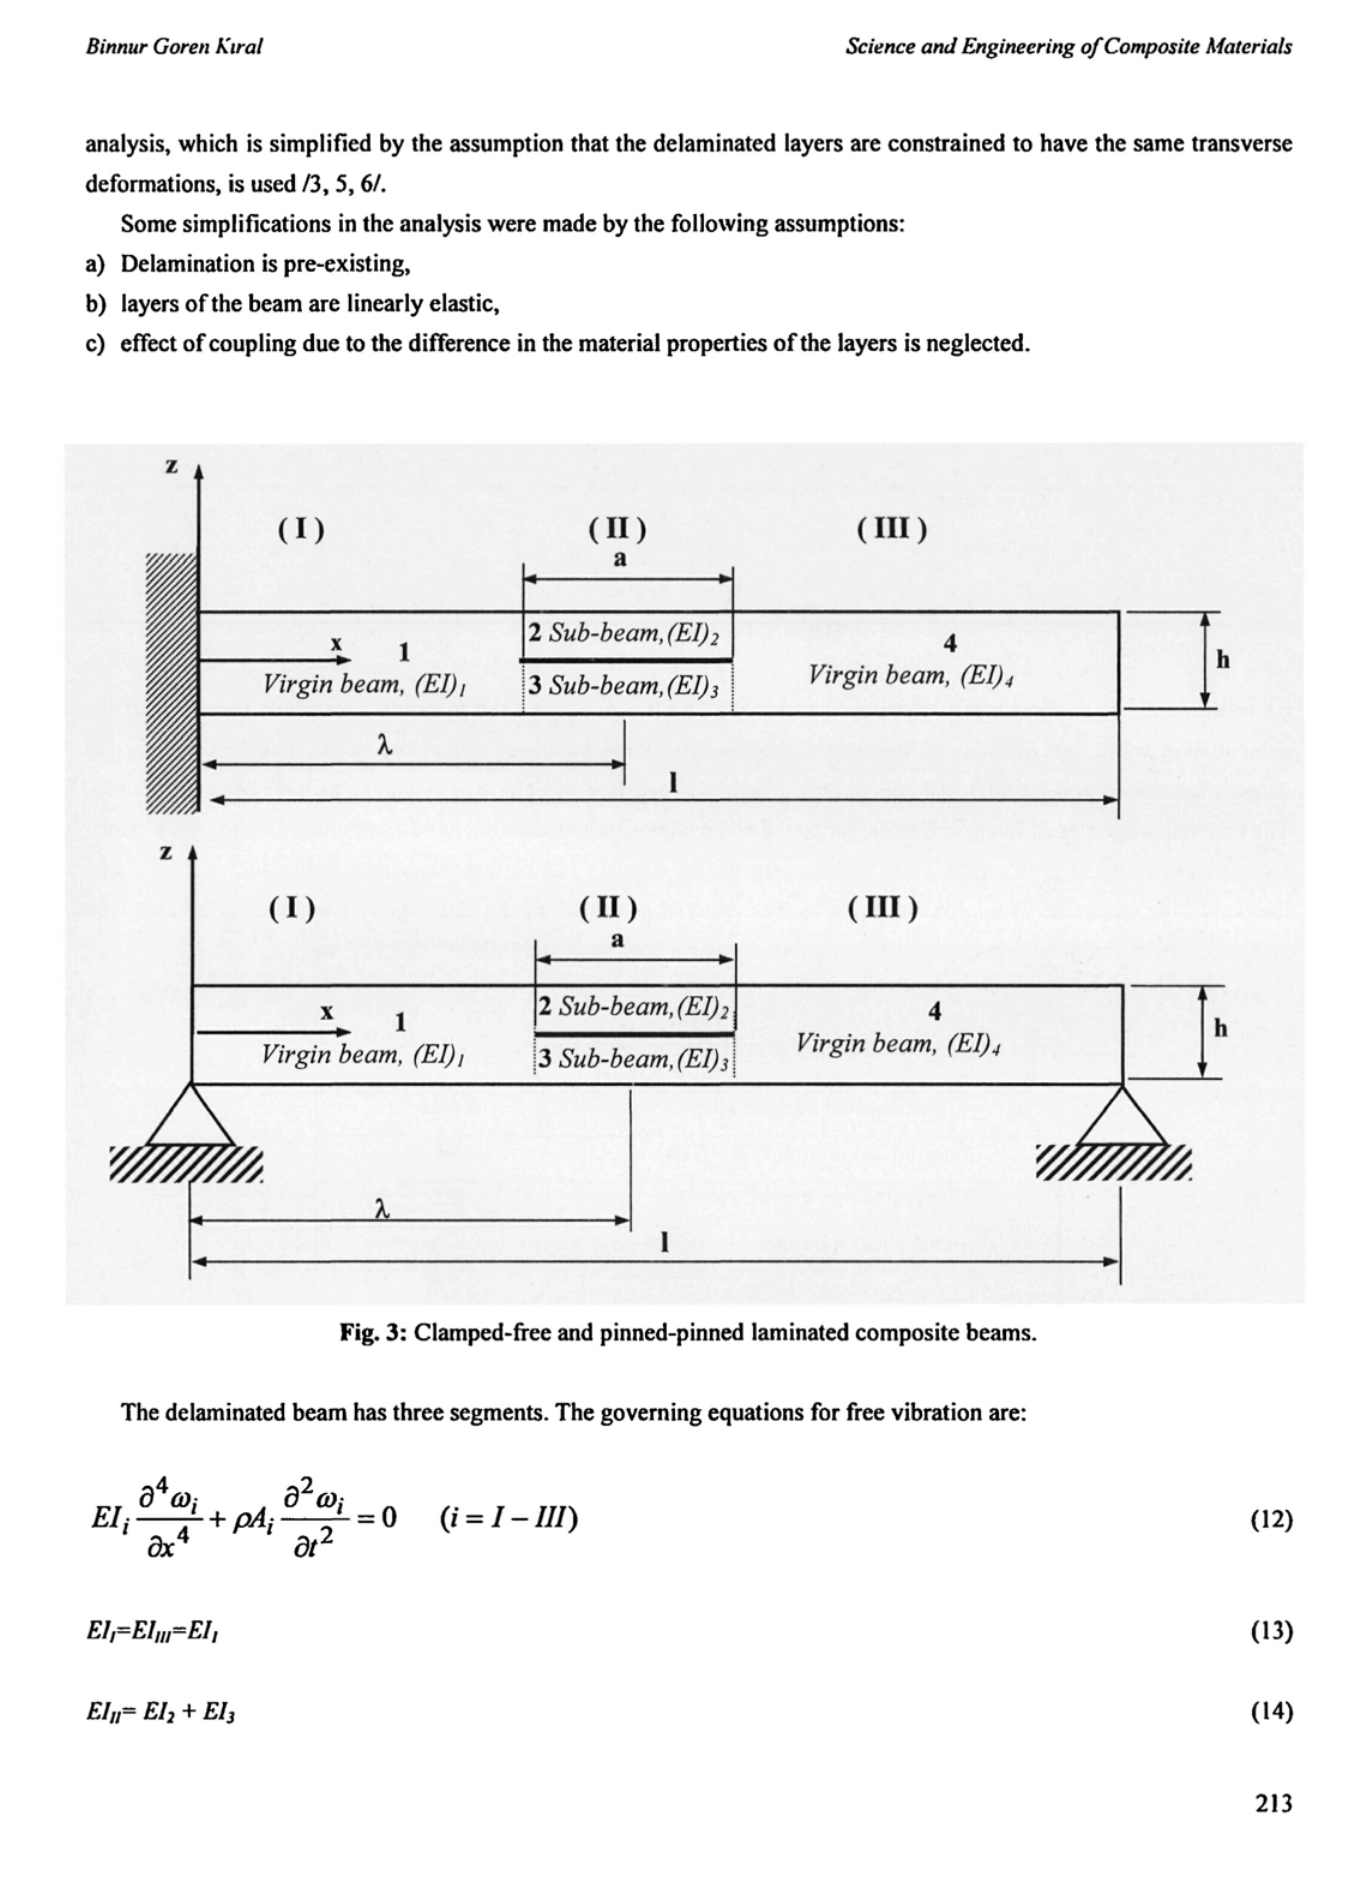
Fig. 3: Clamped-free and pinned-pinned laminated composite